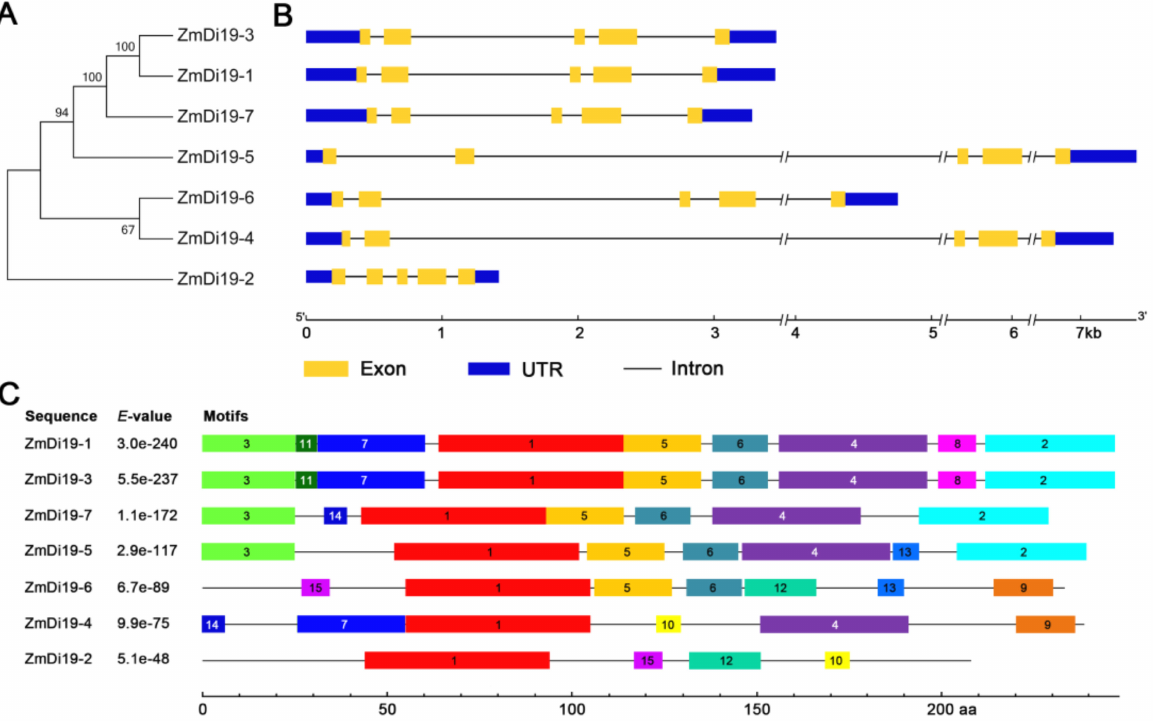
Figure 2. Phylogenetic tree, gene structure, and motif composition of ZmDi19 proteins. ( A ) Unrooted neighbor-joining phylogenetic tree of the ZmDi19 proteins. ( B ) Exon–intron structures of the ZmDi19 genes. Exons are shown as yellow boxes, introns are shown as black lines, and un-translated regions (UTRs) are shown as blue boxes. ( C ) Distribution of conserved motifs in the ZmDi19